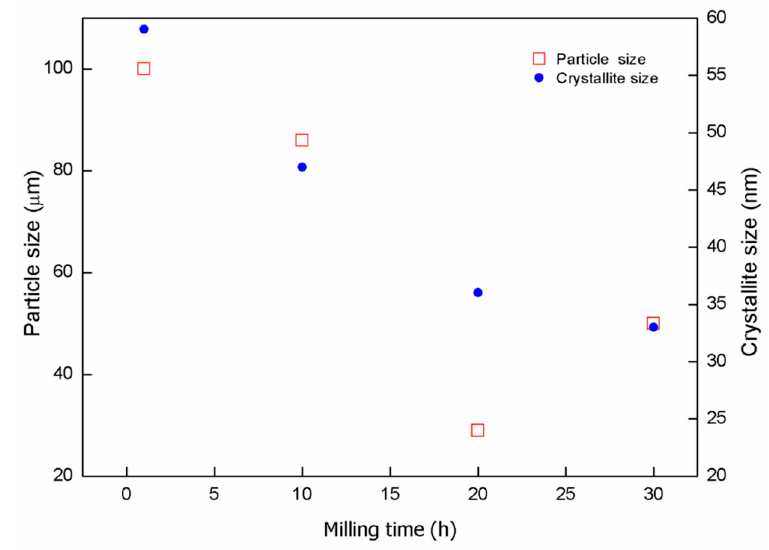
Figure 2. Evolution of particle size and crystallite size as a function of milling time. 173